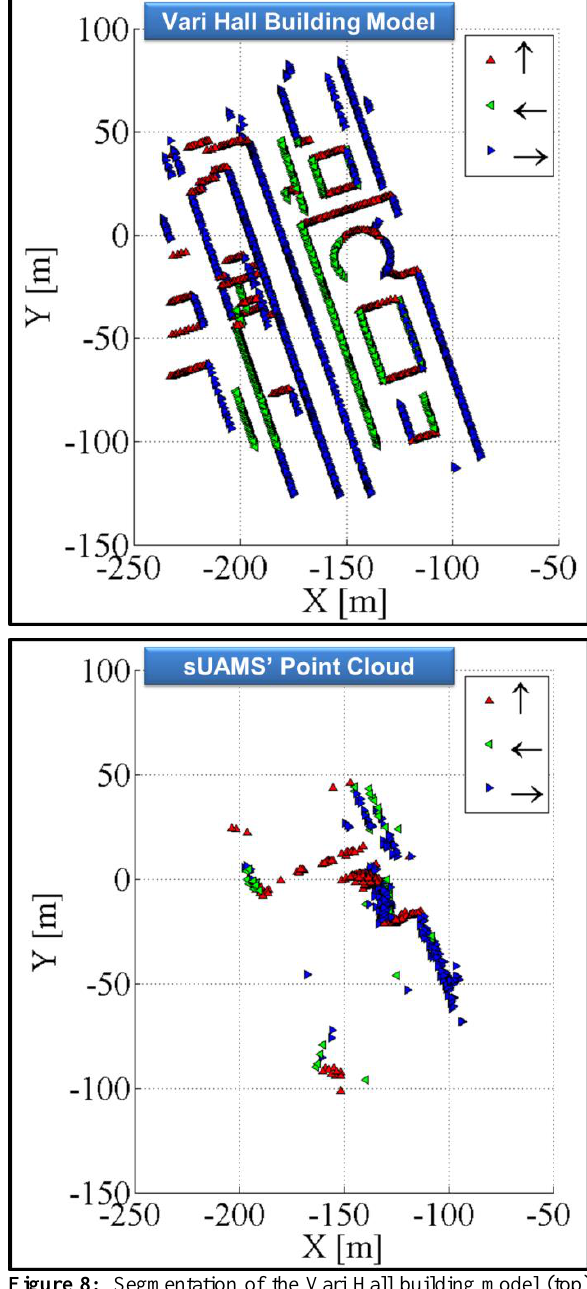
Figure 8: Segmentation of the Vari Hall building model (top) and corresponding point cloud generated from the sUAMS’ data (bottom). Points are segmented into three groups based on their normal vector: Group 1 (red triangles): normals pointing in the positive Y direction (±45 o ), Group 2 (green triangles): normals pointing in the negative X direction (±45 o ), and Group 3 (blue triangles): normal pointing in the positive X direction (±45 o